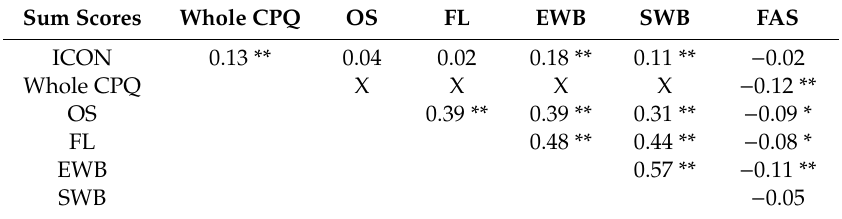
Table 2. Spearman’s correlation coe ffi cients (rho) between Child Perceptions Questionnaire (CPQ), Index of Complexity, Outcome, and Need (ICON), and Family A ffl uence Scale (FAS) sum